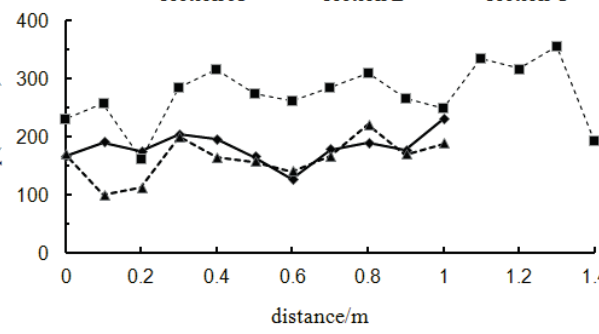
Fig. 5 Hyporheic flux distribution of the different